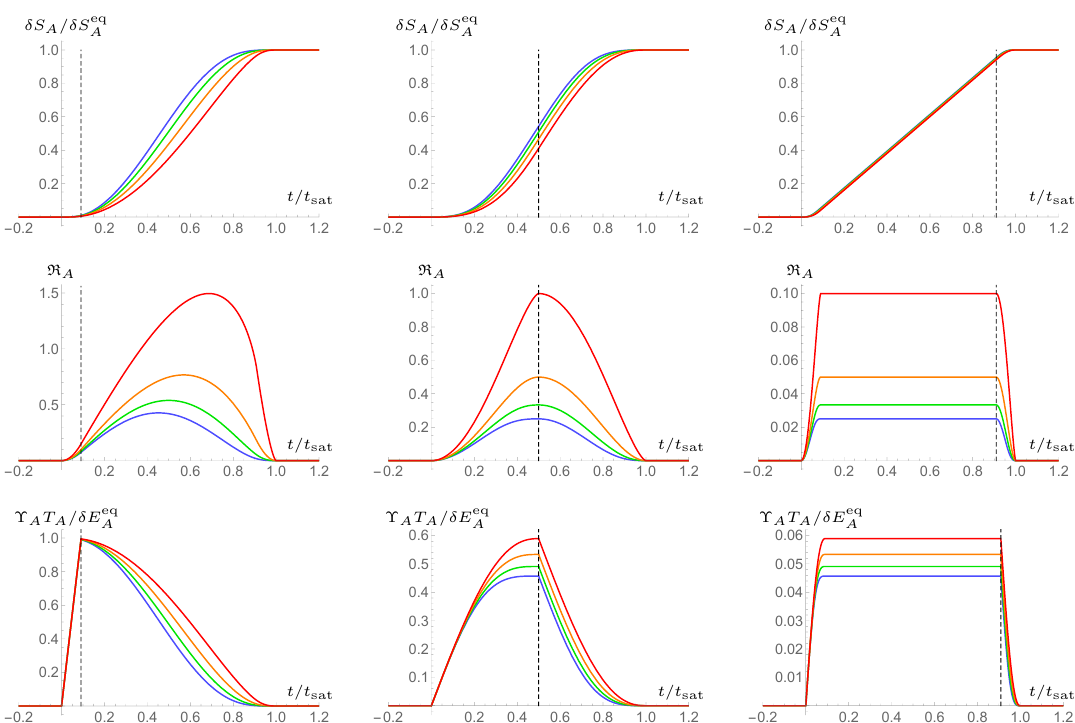
Figure 4 . Plots of entanglement entropy (cid:14)S A ( t ), instantaneous rate of growth R A ( t ) and time- dependent relative entropy (cid:7) A ( t ) for the ball, after a linearly driven quench with p = 1. Di(cid:11)erent values of d = 2 ; 3 ; 4 ; 5 are depicted in red, yellow, green and blue, respectively, and we have chosen f g values t q =t = 0 : 1 ; 1 ; 10 from left to the right. In all plots, the dashed vertical line signals the f g (cid:3) end of the driven phase t = t q